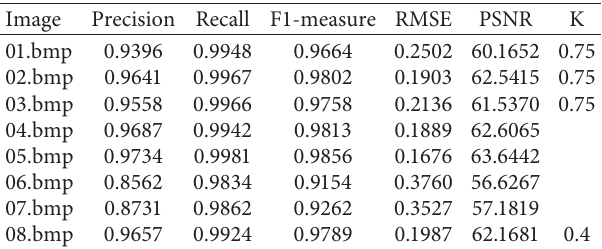
Figure 7: Document binarization with the proposed preprocessing and global thresholding method. (a) Original image. (b) Contrast adjustment. (c) Background mask. (d) Foreground mask. (e) Background compensation mask. (f) Foreground compensation mask. (g) Compensated foreground. (h) Binarized image. Table 2: Performance metrics for some images in the H-DIBCO database using the proposed